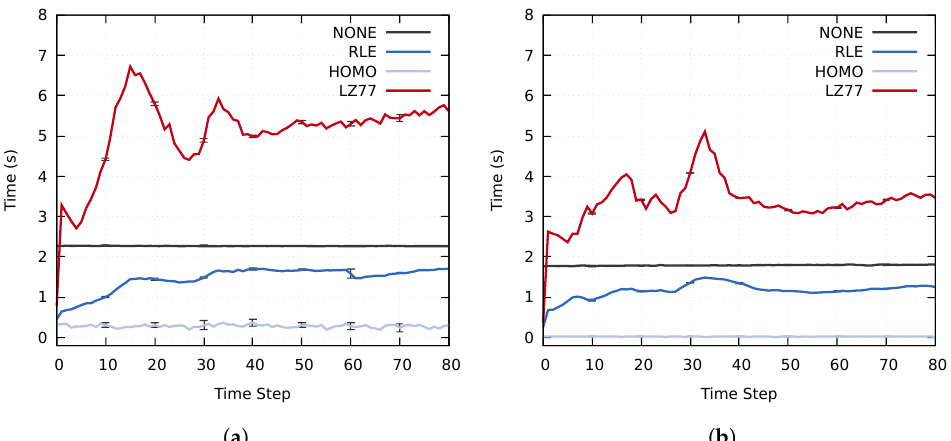
Figure 8. The total compression, load balancing and data transfer times on ( a ) cluster A and ( b ) clus- ter B, using the MF, MY, and MZ data sets. The error bars display the standard deviation of the computation times.